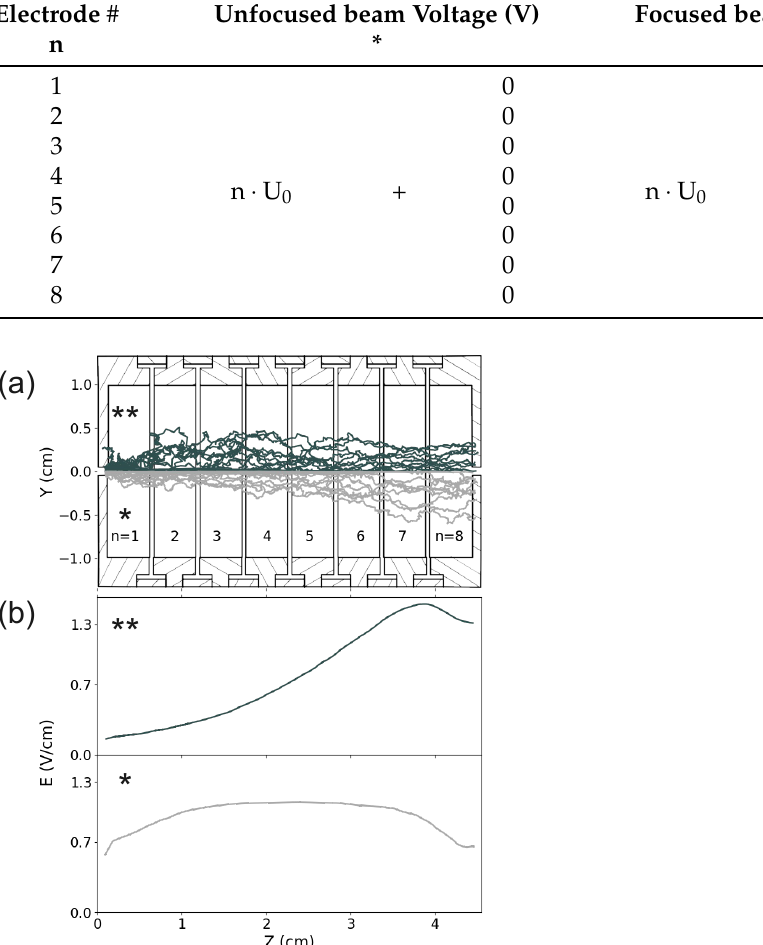
Table 2. Voltage configurations for unfocused (*) and focused beam (**). n is the electrode number. In the case of the unfocused beam, the voltages applied to the different electrodes were scaled by n, whereby values of U 0 between 0.1–10 V were applied in steps of 0.1 V to span a range of E/n 0 between 1–30 Td. For the focused beam, we added different offsets to the unfocused beam configurations as given in the table, where δ = 0.75V and U 0 was varied between 0.1–2.7 V to span in total an E/n 0 range between 1–30 Td.